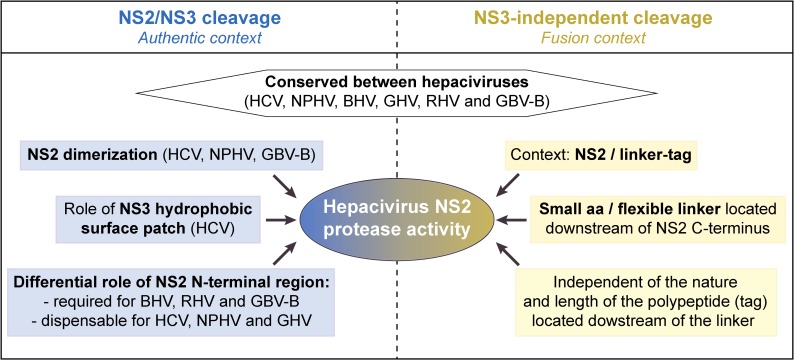
Summary of NS2 protease characteristics across various mammalian hepaciviruses.